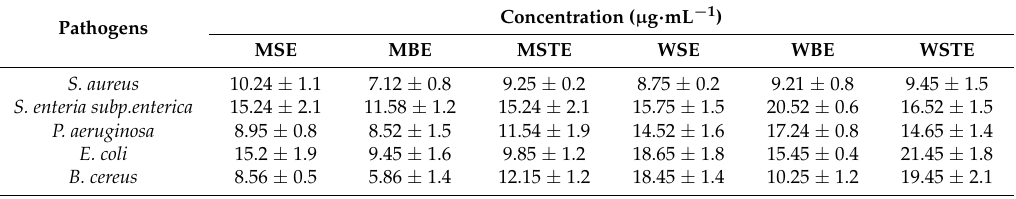
Table 3. Minimal inhibitory concentration of various extracts derived from T. vernicifluum extracts on bacterial pathogens. MeOH seed extract (MSE), MeOH bark extract (MBE), MeOH seed extract (MSTE), water seed extract (WSE), water bark extract (WBE), water stem extract (WSTE). Data are mean ± standard error (SEM, n = 3).